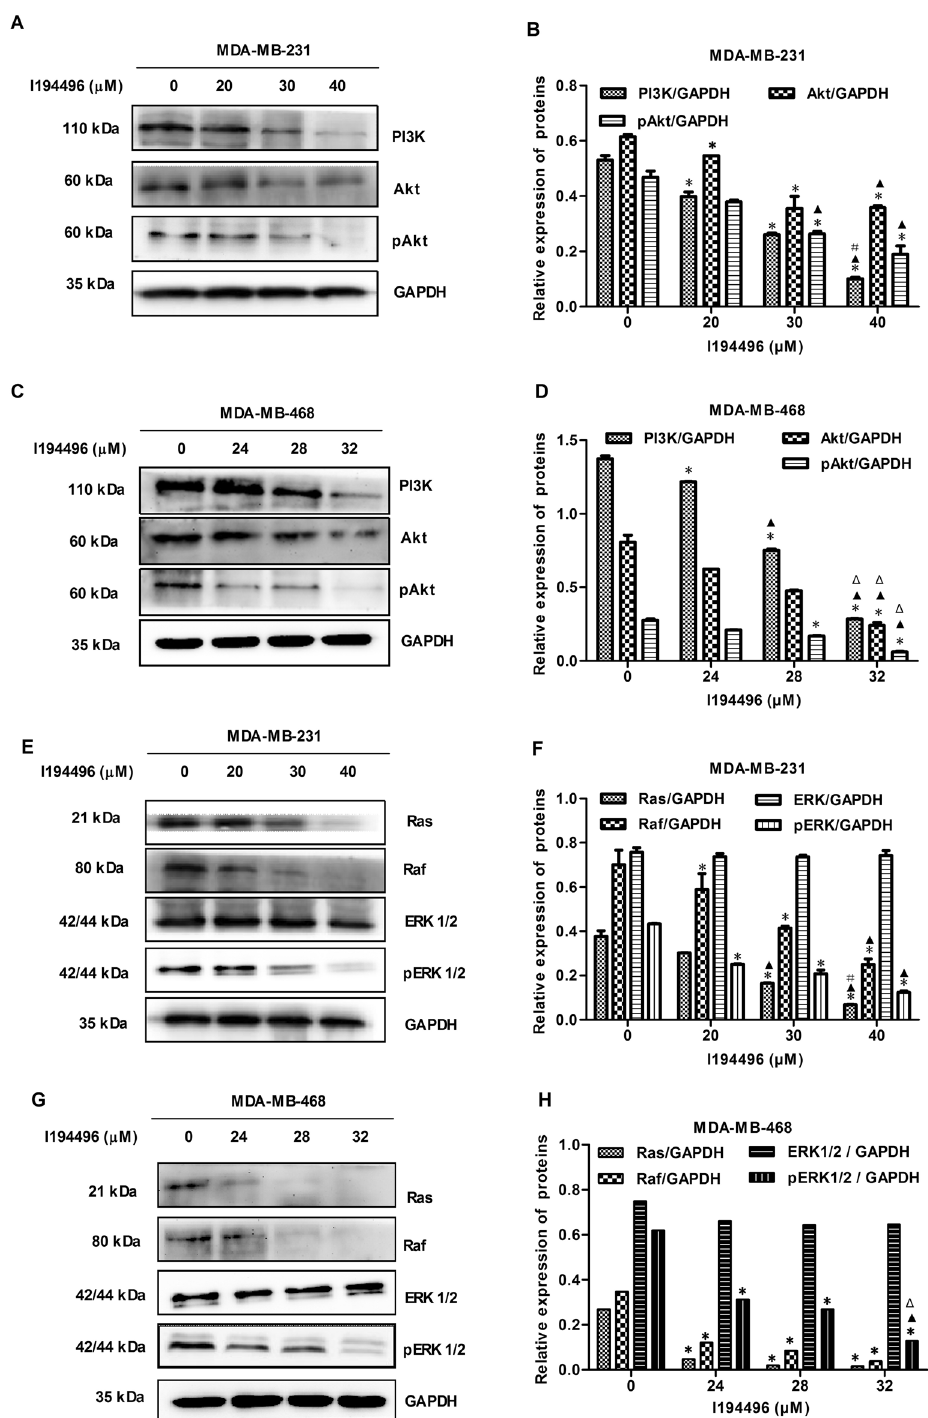
Figure 5. I194496 blocks the PI3K/Akt and Ras/Raf/ERK signaling pathways in human TNBC cells. ( A , B ) The effect of I194496 on PI3K/Akt pathway in MDA-MB-231 cells. *P < 0.05 vs 0 μM I194496 group. ▲ P <